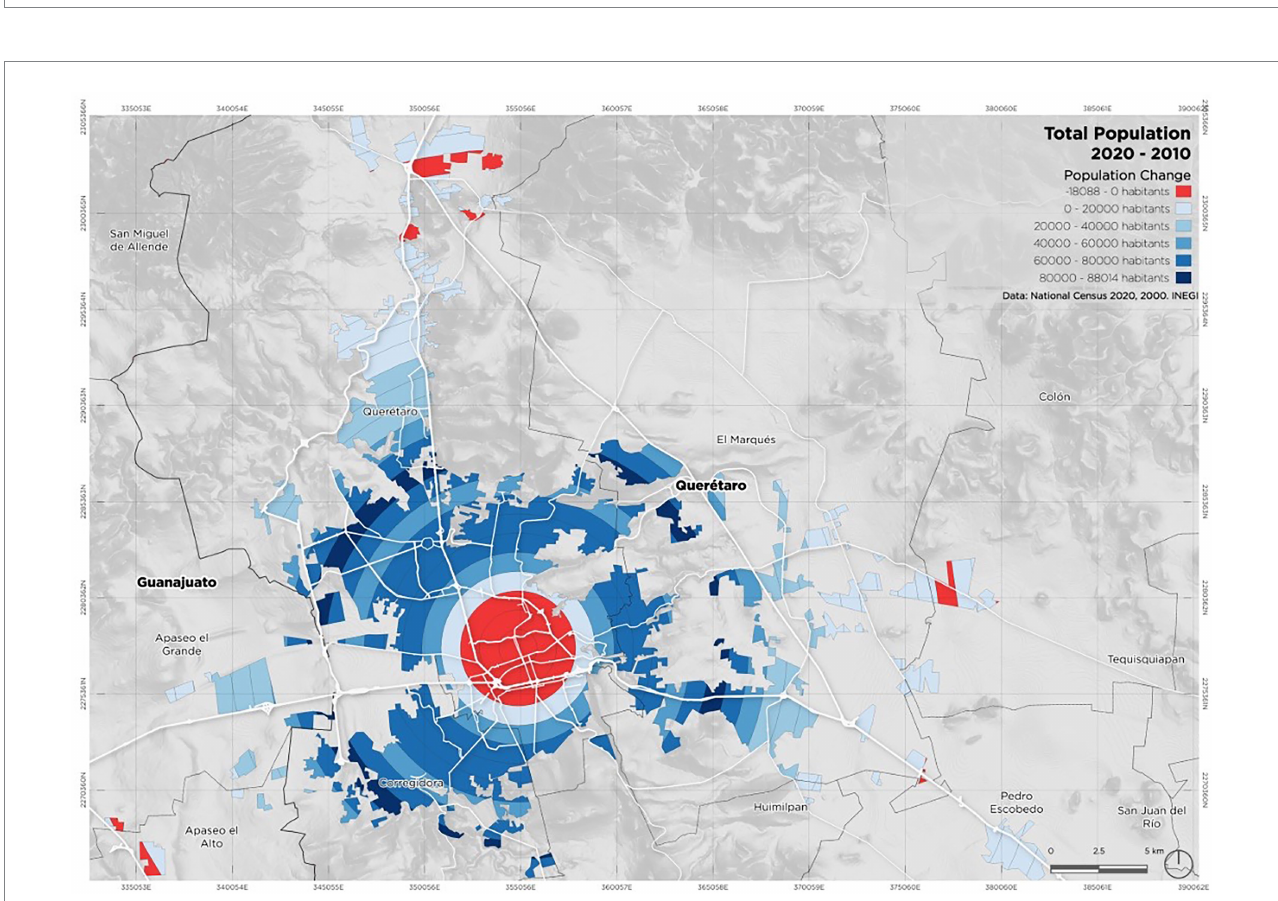
FIGURE 8 Population changes indicated by concentric circles (1-kilometer betweenness) from 2000 to 2020. Own elaboration based on the decennial censuses from iNEGI for 2000, 2010 and 2020 by